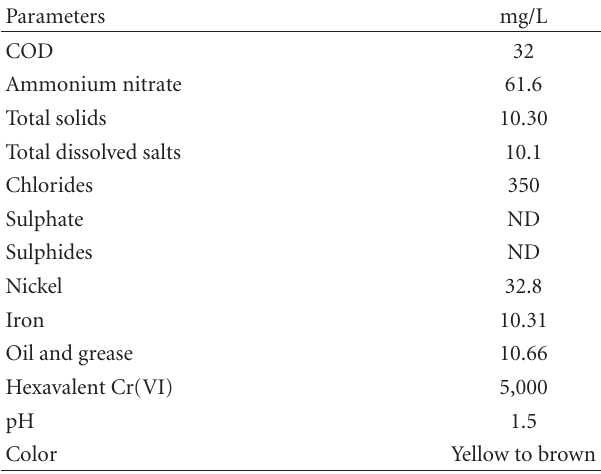
Table 2: Physical and chemical characteristics waste water collected from e ffl uent of electroplating